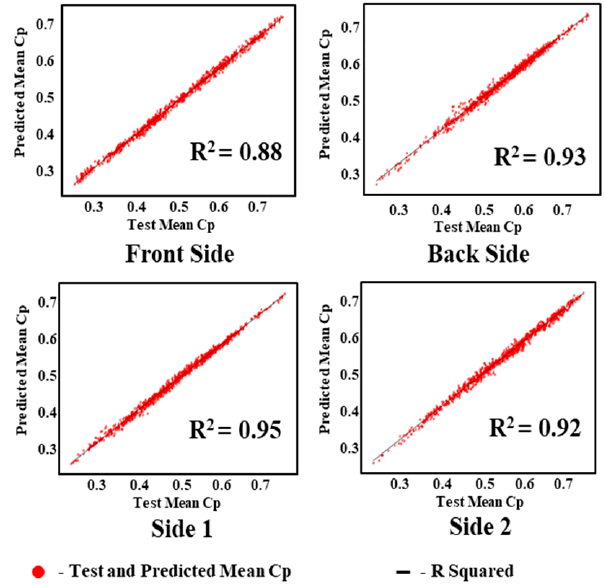
Figure 21. Predicted mean pressure coefficient by KNN.